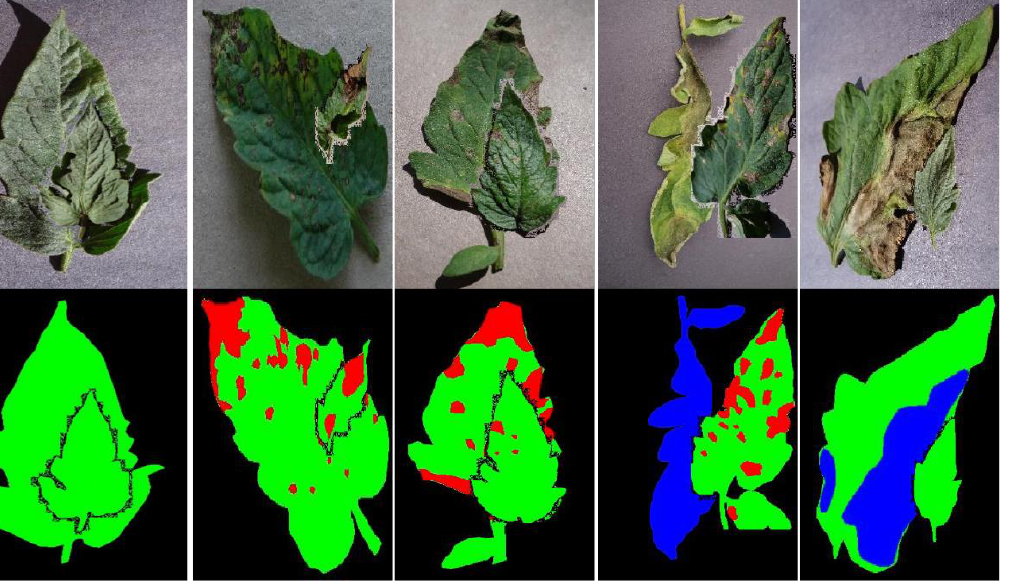
Figure 2. Examples of the copy – paste augmented TDSD; green is the leaf, red is the early blight spot, blue is the late blight spot, and black is the background.